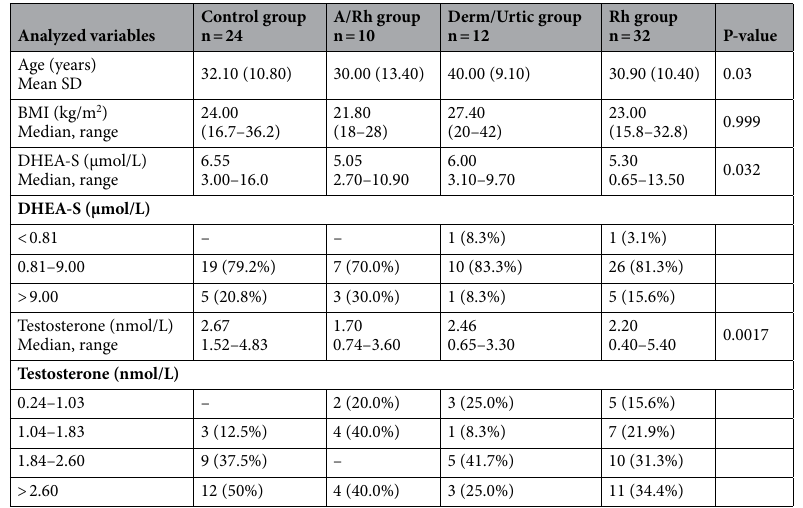
Table 1. Age, BMI and serum concentrations of total testosterone and DHEA-S in allergic patients and controls. n—number of subjects; DHEA-S—dehydroepiandrosterone sulfate; Rh—allergic rhinitis; A/ Rh—allergic asthma with rhinitis; Derm/urtic—allergic dermatitis/acute urticaria; BMI—body mass index (normal = 18.5–24.9 kg/m 2 , overweight = 25–29.9 kg/m 2 , obese > 30 kg/m 2